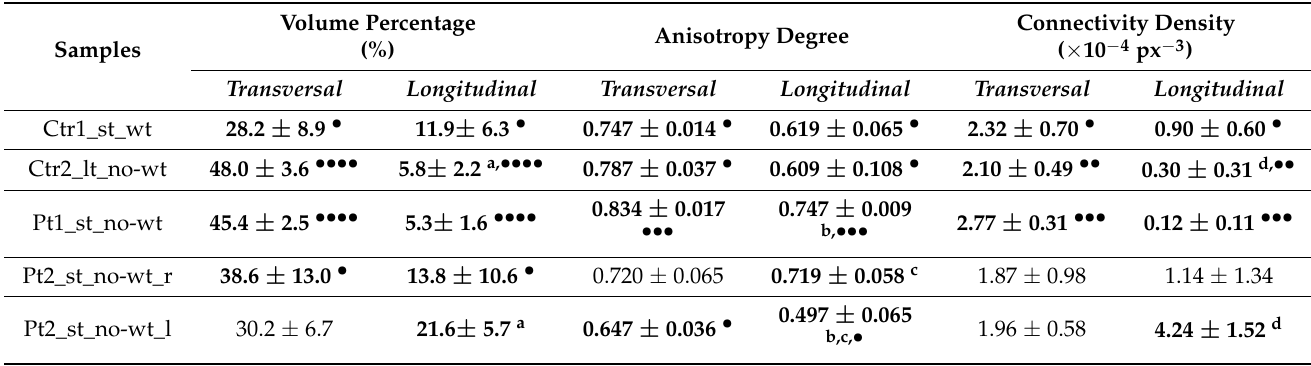
Table 4. Welch t -test between morphometric data in transversal vs. longitudinal collagen bundles; Brown–Forsythe and Welch ANOVA test, Dunnett’s multiple comparisons between samples per parameter (only deep learning data). Test executed by GraphPad Prism 6.0 (GraphPad, Inc.,